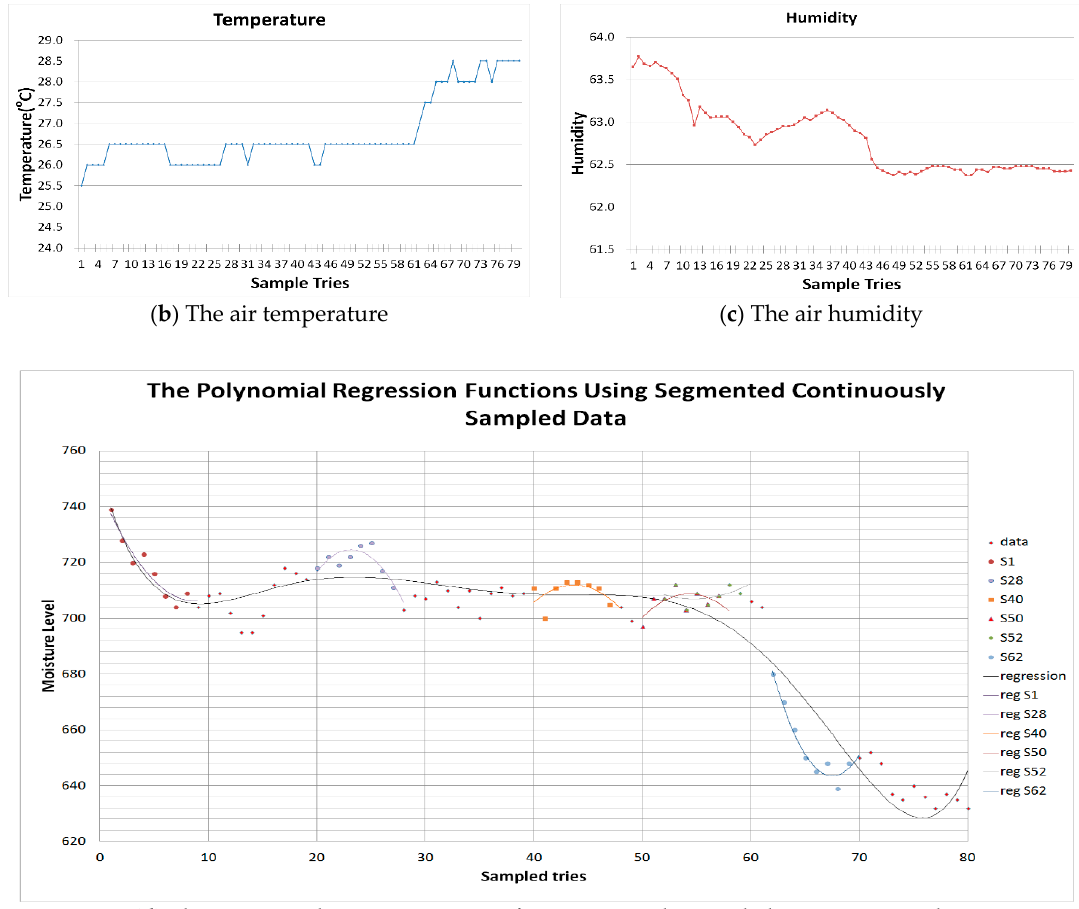
Figure 5. The regression function of the sampled moisture data. The dimension of moisture level is 0–1023. ( a ) The regression curves of the 2nd, 3rd, 4th, 5th, and 6th order polynomial functions for total sampled data. ( b ) The air temperature of this experiment. ( c ) The air humidity of this experiment. ( d ) The segmented regression curves. The segment size in this figure is 8 continuously sampled moisture records. Each S k | k = {1, 28, 40, 50, 52, 62} in this figure is the regression curve using the data from the kth record to the (k + 8)th one. This regression curve is used by the SMF model to forecast the moisture value of the (k + 9)th sampled